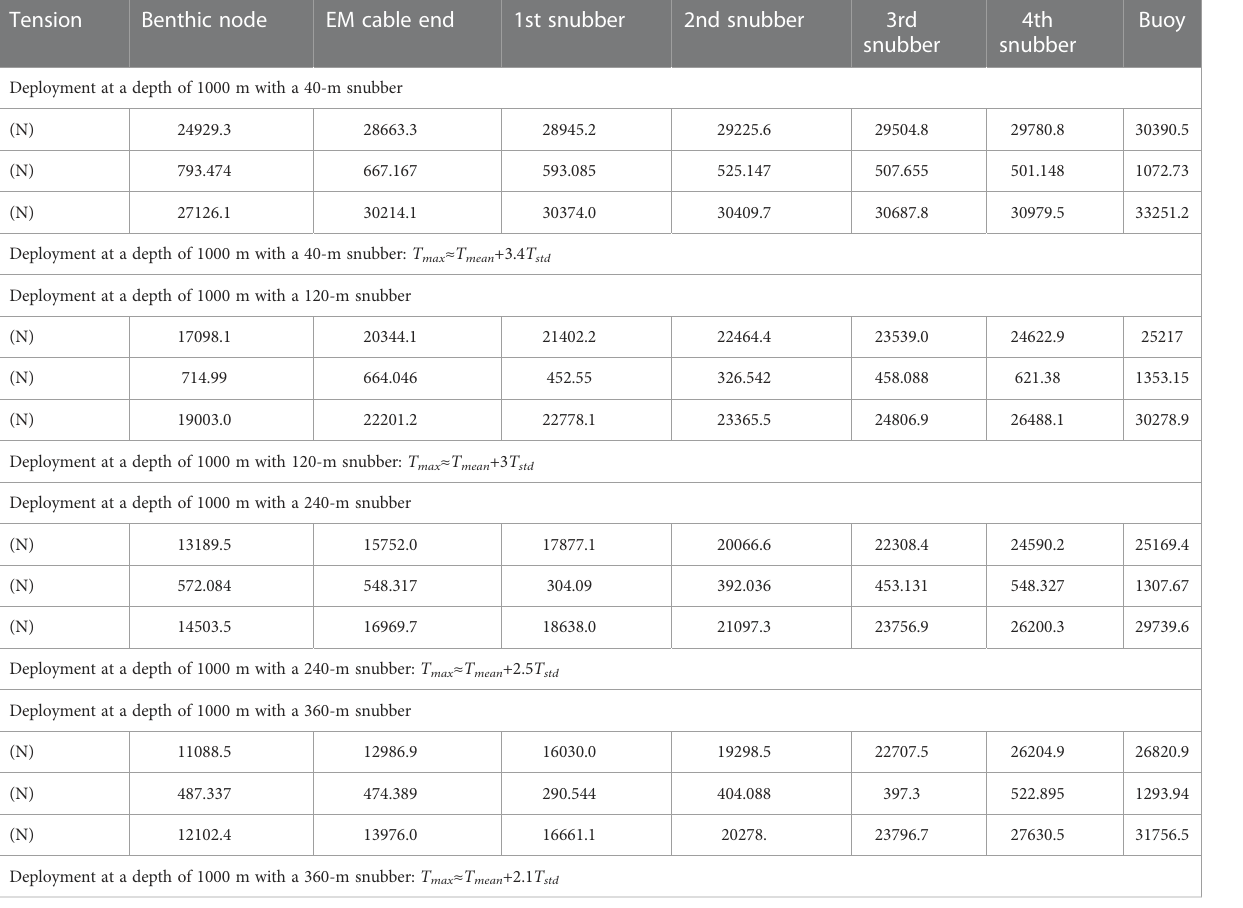
TABLE 10 Tension from the dynamic analysis for different lengths of